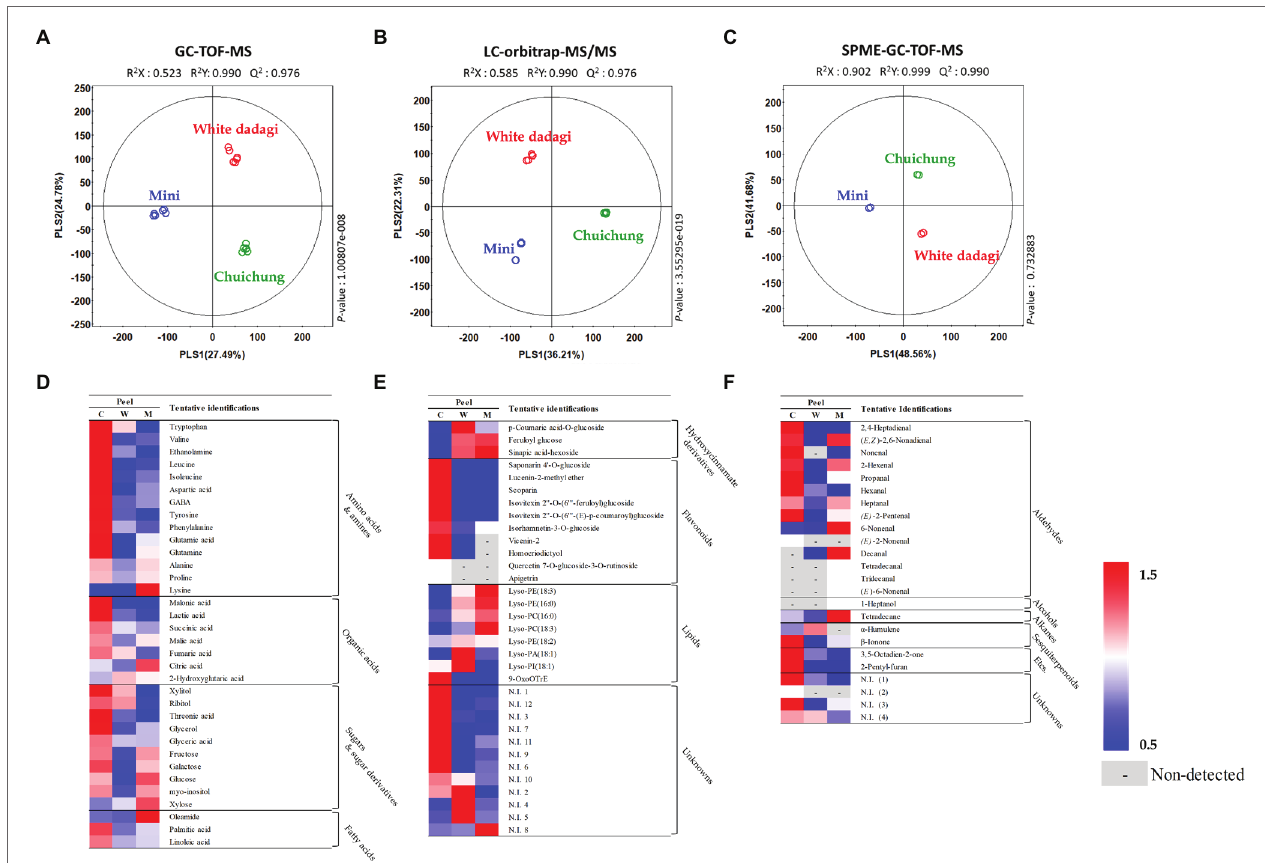
FIGURE 4 | Partial least squares-discriminant analysis (PLS-DA; A–C ) score plots for metabolites in three different cucumber peel based on GC-TOF-MS (A) , UHPLC-LTQ-Orbitrap-MS/MS (B) , and HS-SPME-GC-TOF-MS (C) dataset. Heat map analysis of different cucumber peel based on GC-TOF-MS (D) , UHPLC-LTQ- Orbitrap-ESI-MS/MS (E) , and HS-SPME-GC-TOF-MS (F) data. Heat map representation of the relative abundance of significantly discriminant metabolites (VIP > 0.7, p < 0.05) based on PLS-DA model. Peel of Chuichung ( ), White Dadagi ( ), and Mini ( ) samples. GC-TOF-MS, gas chromatography time-of-flight mass spectrometry; UHPLC-LTQ-Orbitrap-MS/MS, ultrahigh-performance liquid chromatography–linear trap quadrupole-orbitrap–tandem mass spectrometry; HS-SPME- GC-TOF-MS, headspace-solid phase microextraction gas chromatography time-of-flight mass spectrometry; VIP, variable importance projection; PLS-DA, partial least squares-discriminant